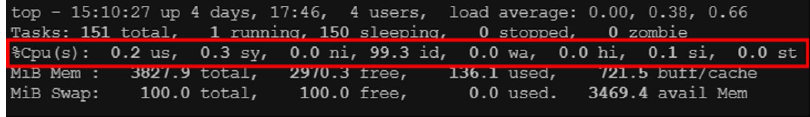
Figure 6. The system information of SCADA server in idle status.